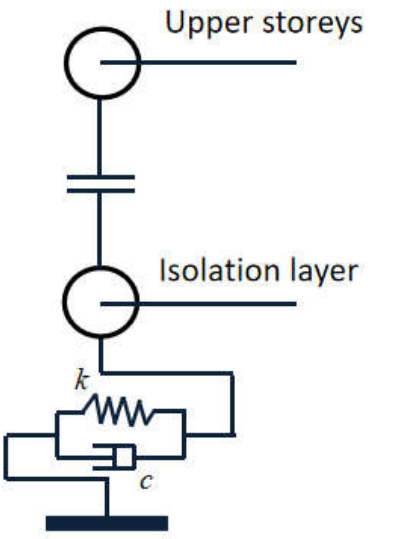
Figure 18. Equivalent simplified model of isolated structure.